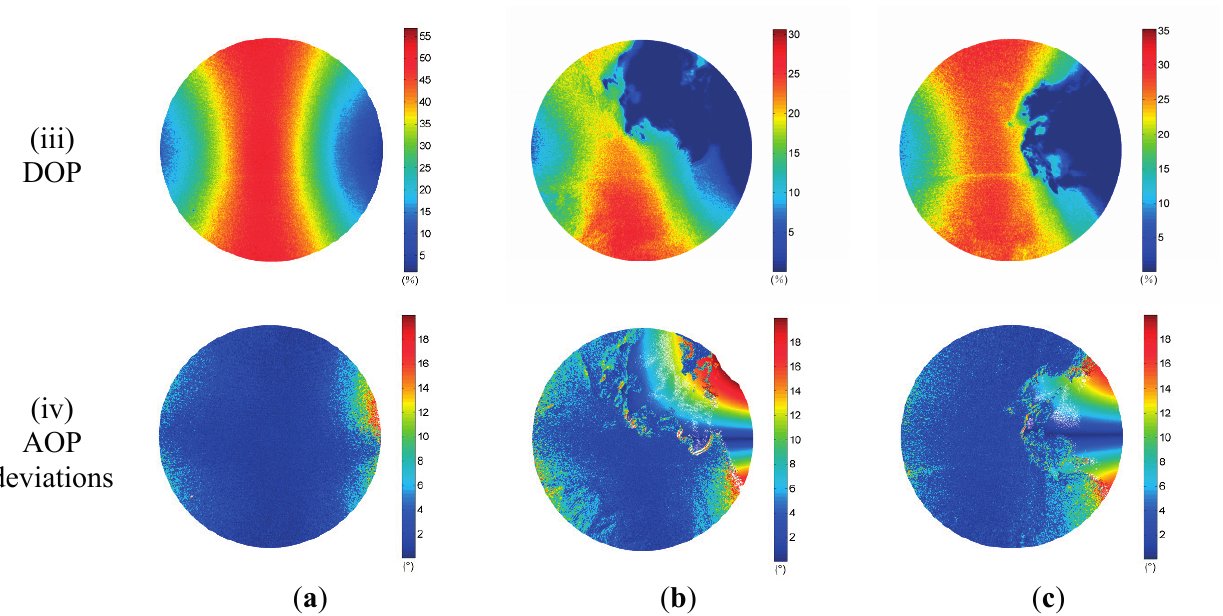
Figure 5. Color photo, AOP, and DOP were measured by our instrument in blue part of the spectrum in ( a ) Clear sky; ( b ) Cloudy sky I; and ( c ) Cloudy sky II. Row (iv) is the AOP